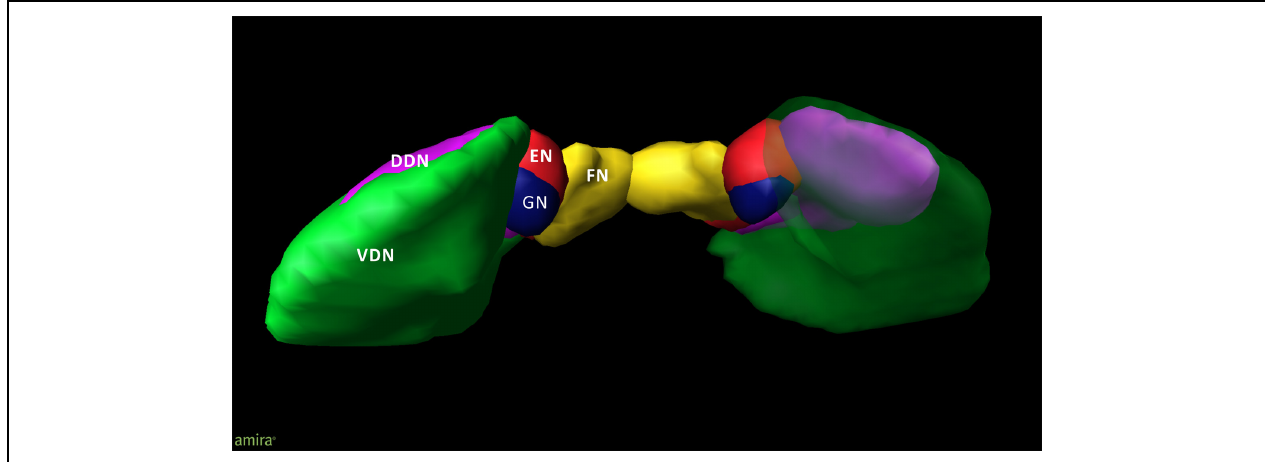
FIGURE 2 | 3D model of the deep cerebellar nuclei (posterior to anterior view) of an individual brain (post mortem brain10); visualization by Amira 5.6.0 (www . amira . com). Dorsal dentate nucleus (DDN; magenta); ventral dentate nucleus (VDN; green); emboliform nucleus